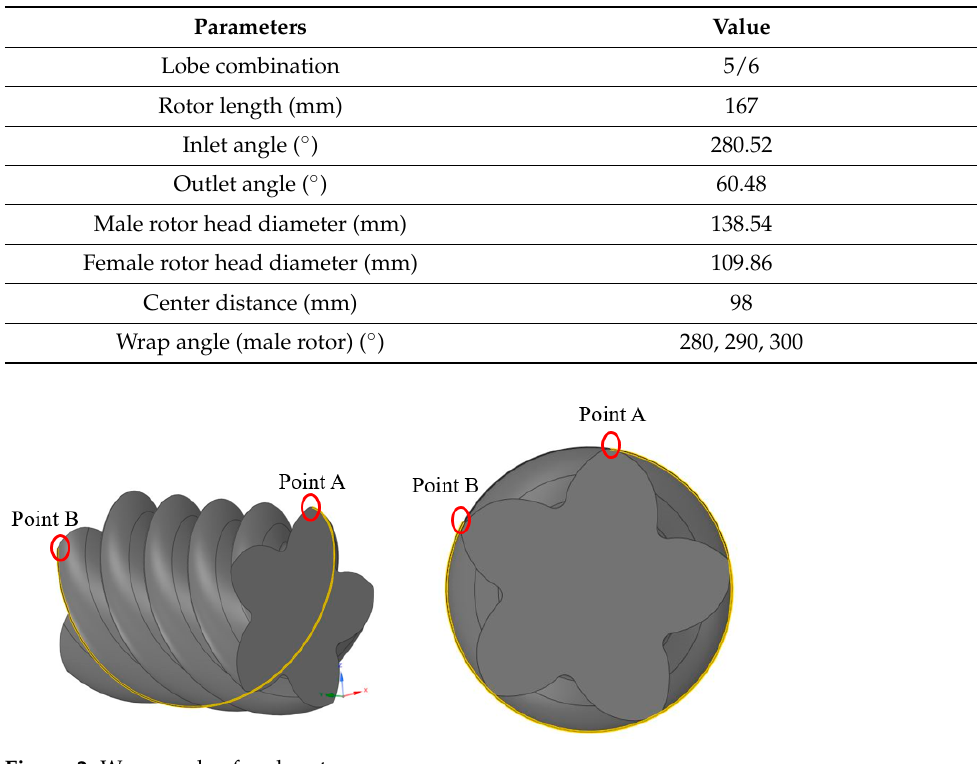
Figure 2. Wrap angle of male